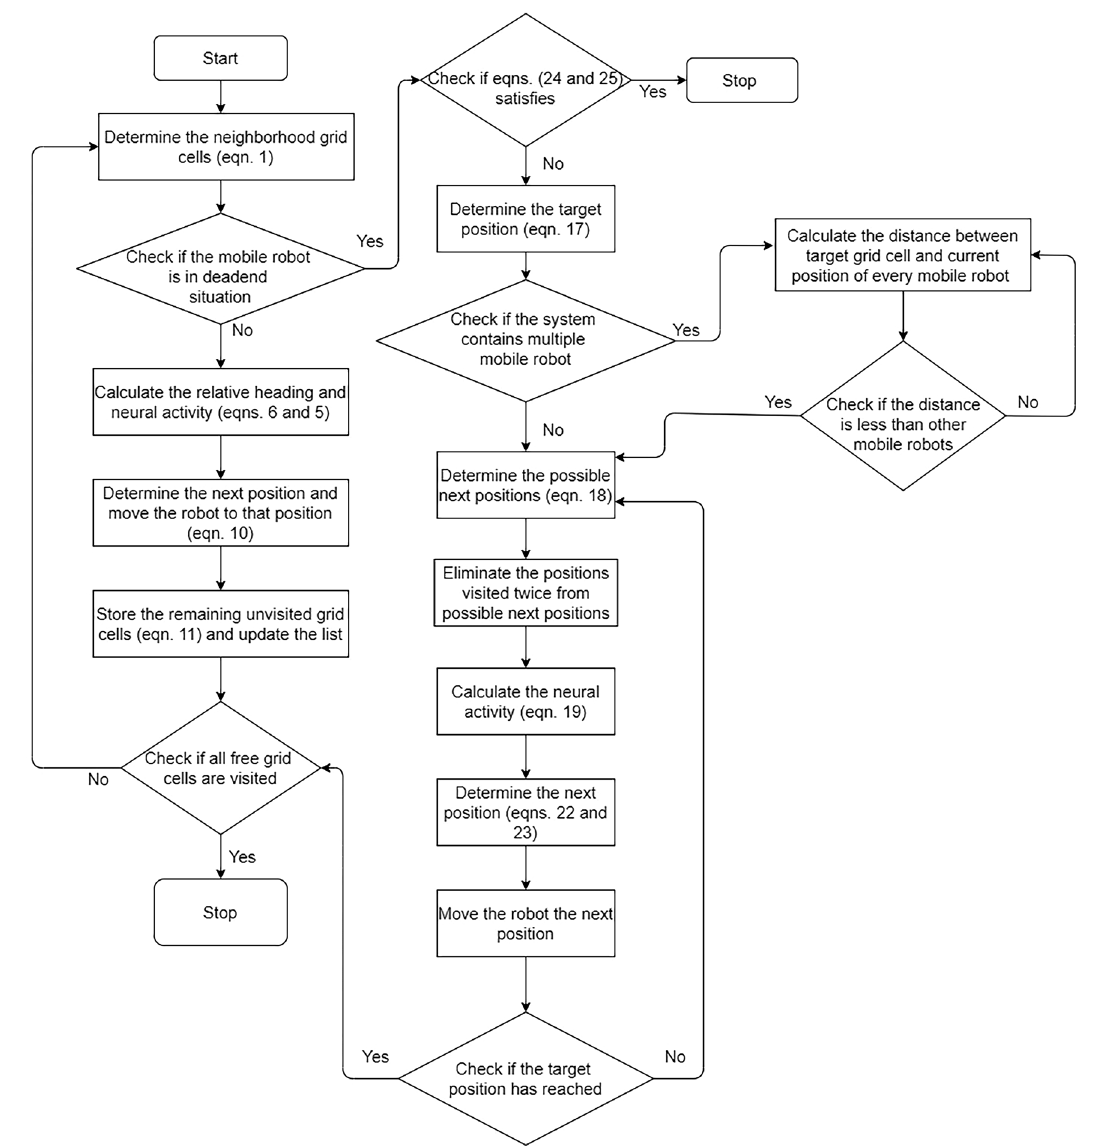
Fig. 3 Flowchart of the proposed